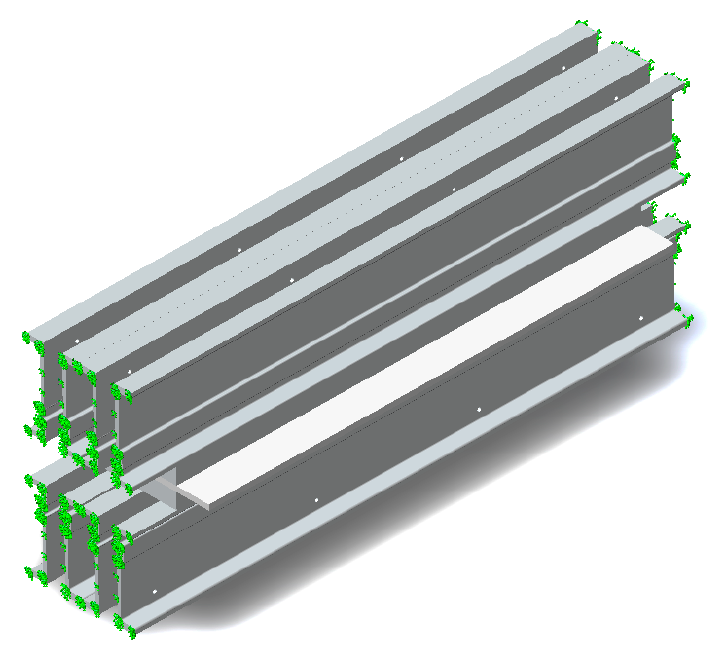
Figure 4. Restrictions imposed on the construction elements of the belt vulcanization press.